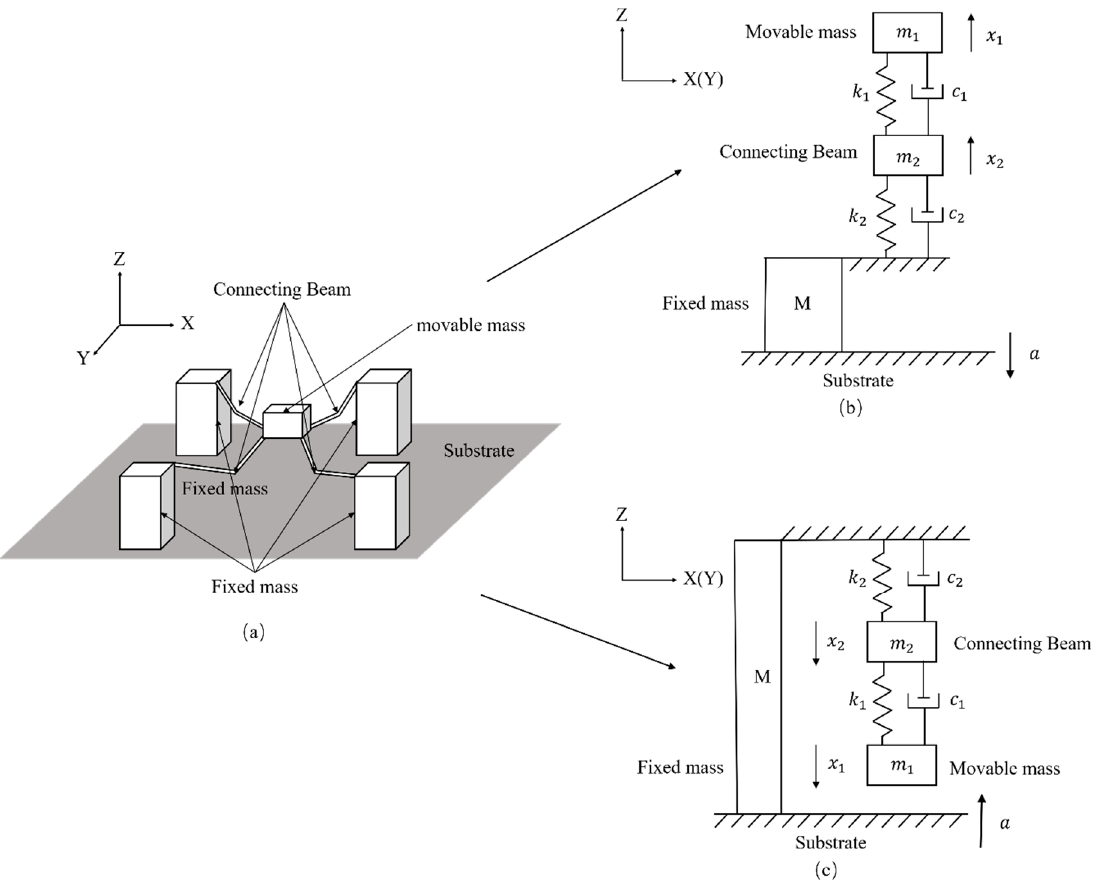
Figure 1. A two-degree-of-freedom (2DOF) model of a microelectromechanical systems (MEMS) tuning fork gyroscope. ( a ) Simplified schematic of the two-degree-of-freedom (2DOF) model; ( b ) schematic view of motion and stress of the model when the system is impacted along the negative Z-axis; ( c ) schematic view of motion and stress of the model when the system is impacted along the positive Z-axis.